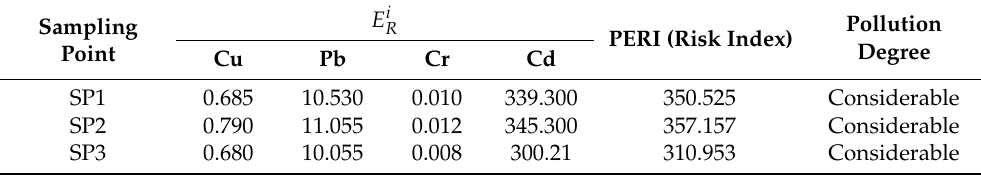
Table 6. Potential ecological risk factor ( E i Victoria,